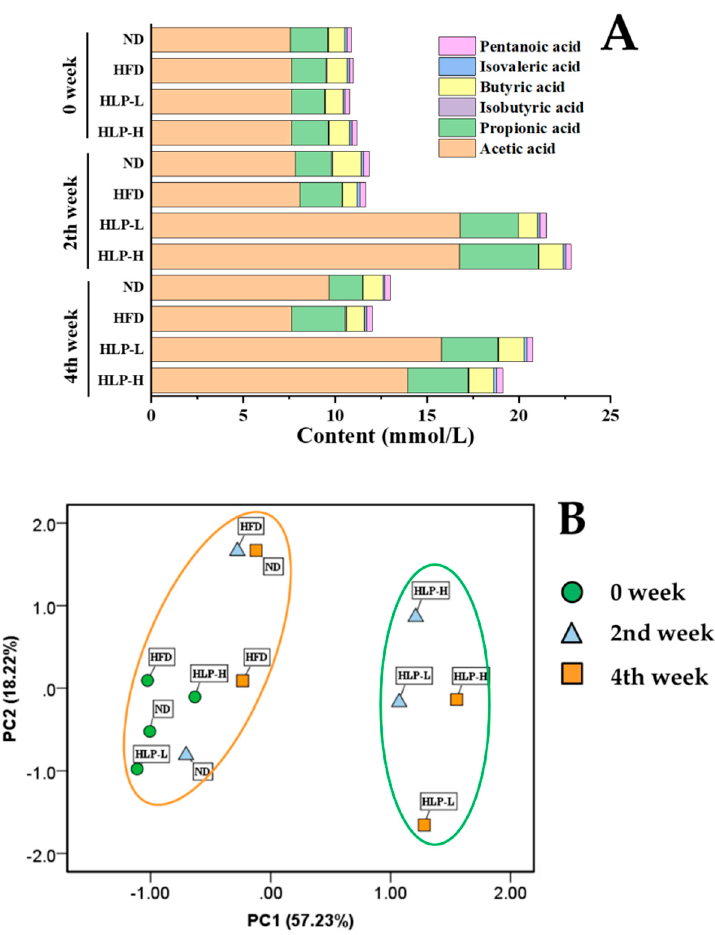
Figure 4. E ff ects of HLP on short-chain fatty acids (SCFAs). The content of SCFAs in feces ( A ). PCA score plot for SCFAs ( B ) ( n = 8).